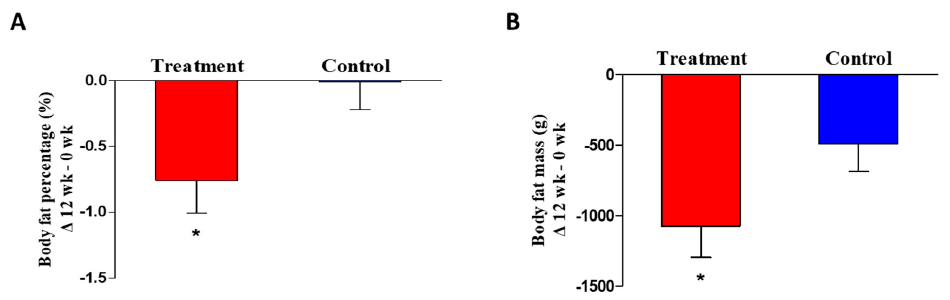
Figure 2. ( A ) body fat percentage, ( B ) body fat mass between treatment (COEC) and control (placebo) groups at 12 weeks. * p < 0.05 vs. control (paired t -test).